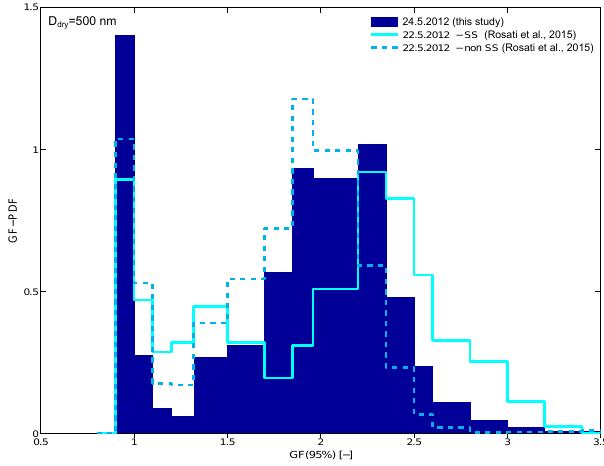
Figure 14. Comparison of GF-PDFs recorded with the WHOPS on board of the Zeppelin for two different flight days: 24 May 2012 (this study) and on 22 May 2012 (Rosati et al., 2015). Both flights were located close to Cabauw and results are representative for par- ticles with D dry =